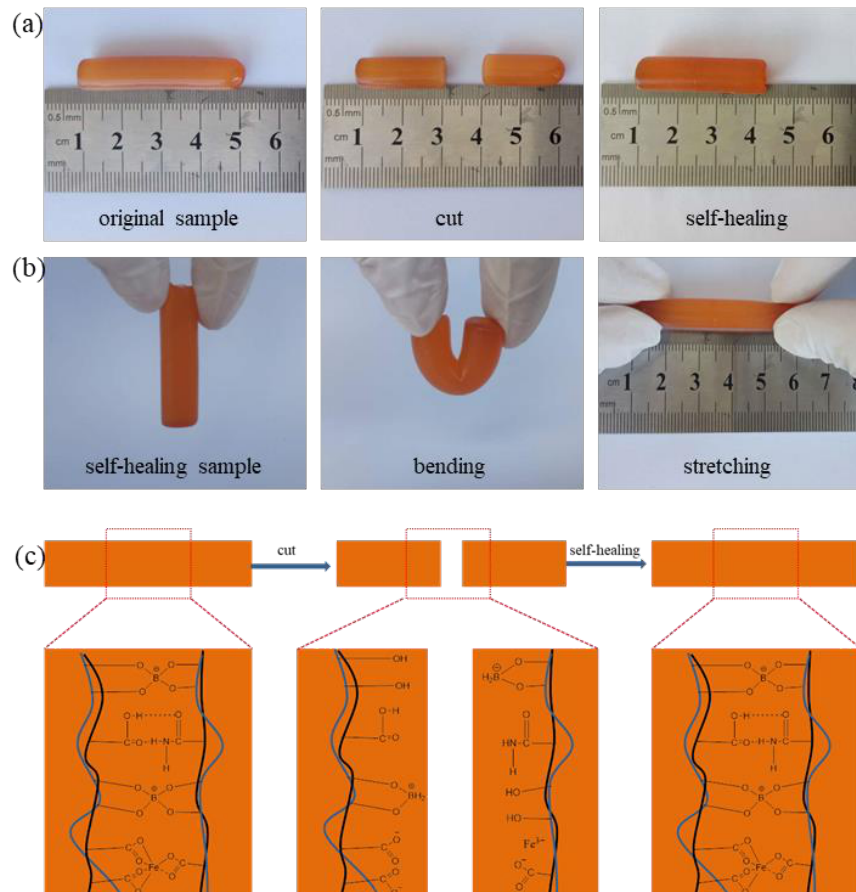
Figure 8. ( a , b ) presenting the macroscopic self-healing behavior of P(AAc- co -Am) / PVA double network hydrogels (Gel-9); ( c ) Schematic of the self-healing mechanism of P(AAc- co -Am) / PVA double network hydrogels.